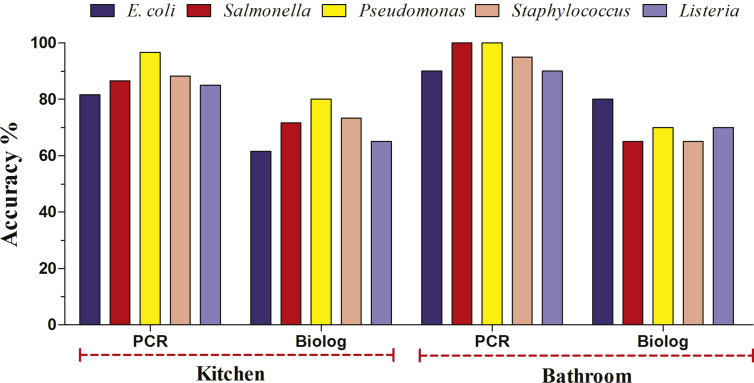
Accuracy percentages of bacterial isolates confirmation via Biolog GEN III system and PCR from biofilm collected from kitchen (a) and bathroom drains (b).